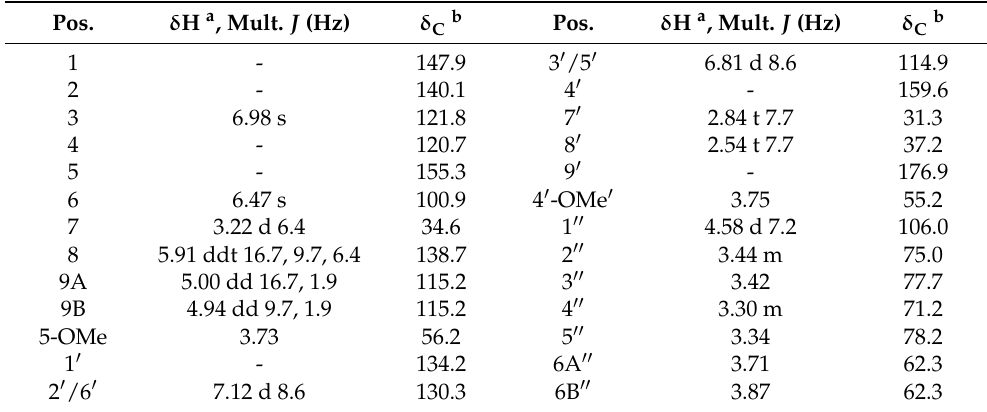
Table 2. 1 H- and 13 C-NMR data of 2 (in CD 3 OD; δ in ppm, J in Hz).